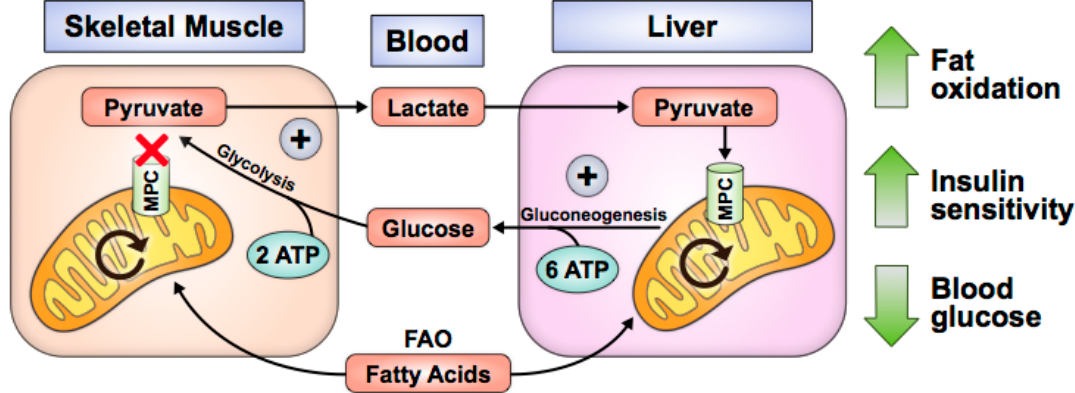
Figure 2. Skeletal muscle MPC disruption increases glucose uptake, fat oxidation, and insulin sensitivity. Fatty acid oxidation (FAO) provides ATP for energetically futile Cori Cycling.